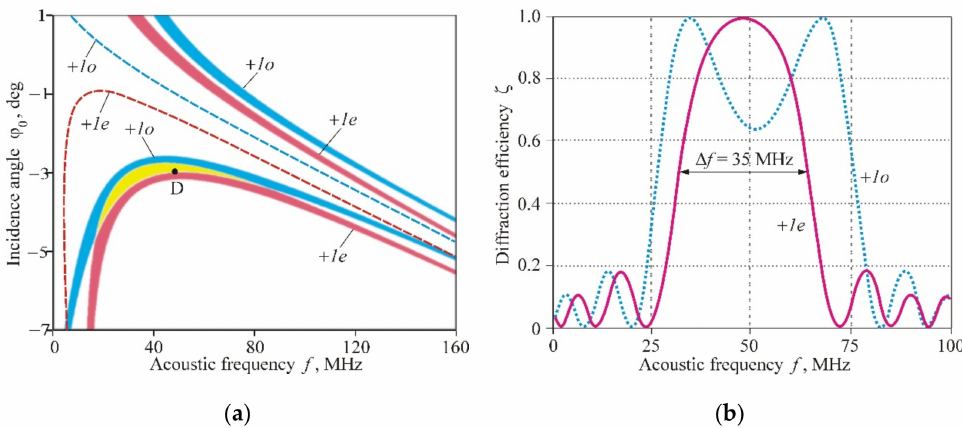
Figure 9. AO deflector of nonpolarized light: ( a ) Combined areas of AO interaction for + 1e (red color) and + 1o (blue color) diffraction branches, the overlap area is shown by yellow color; ( b ) Frequency characteristics of the AO deflector in the case of unpolarized light.